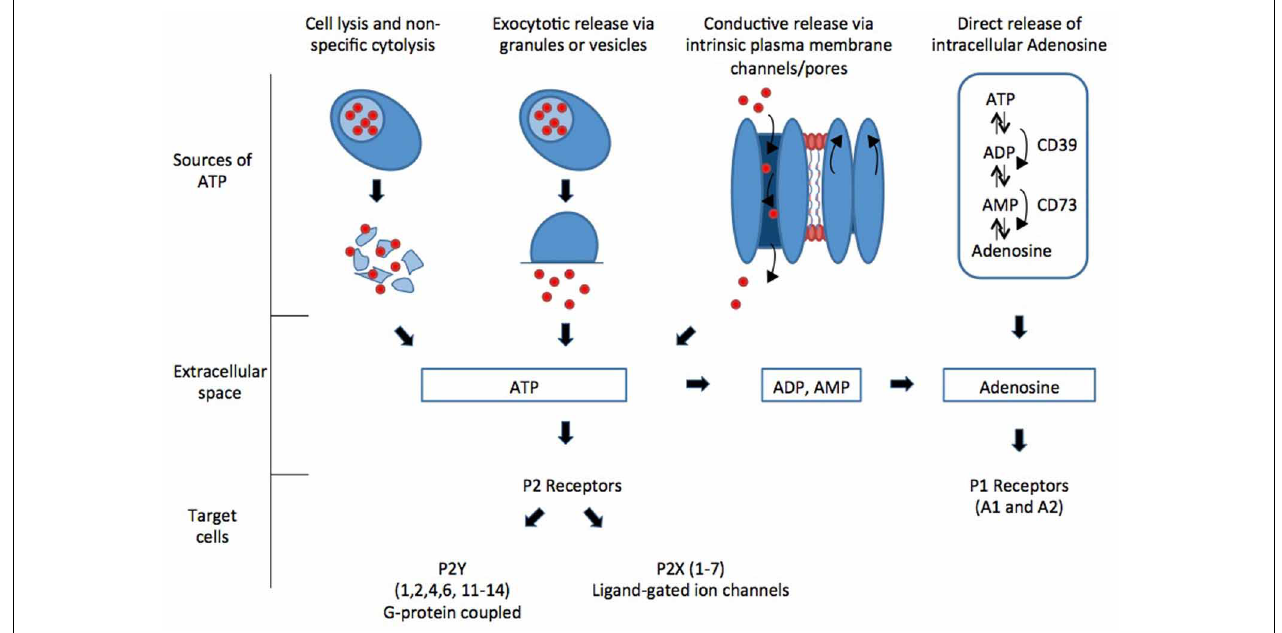
FIGURE 1 | Intracellular purines are released into the extracellular space by various mechanisms and act upon extracellular purinergic